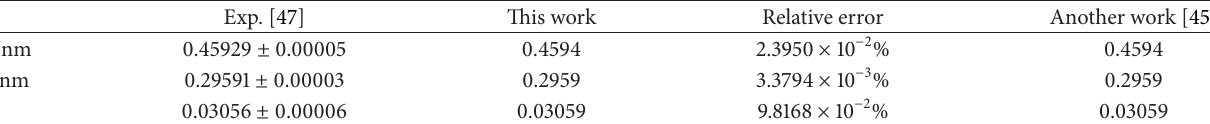
Table 1: Comparisons of lattice constants between calculation (including those obtained in another work) and experiment.